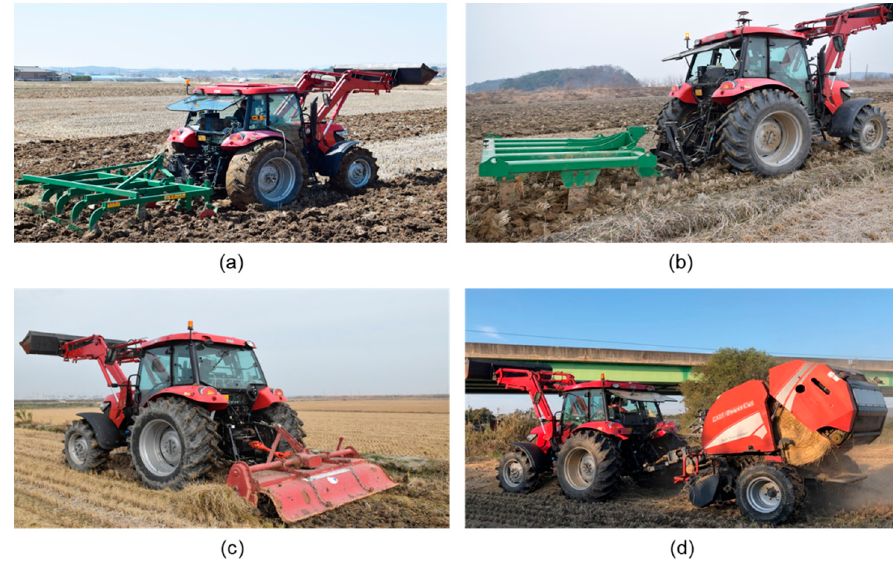
Figure 6. Field experiments of major agricultural tractors: ( a ) moldboard plow tillage, ( b ) subsoiler tillage, ( c ) rotary tillage, and ( d ) baler operation.